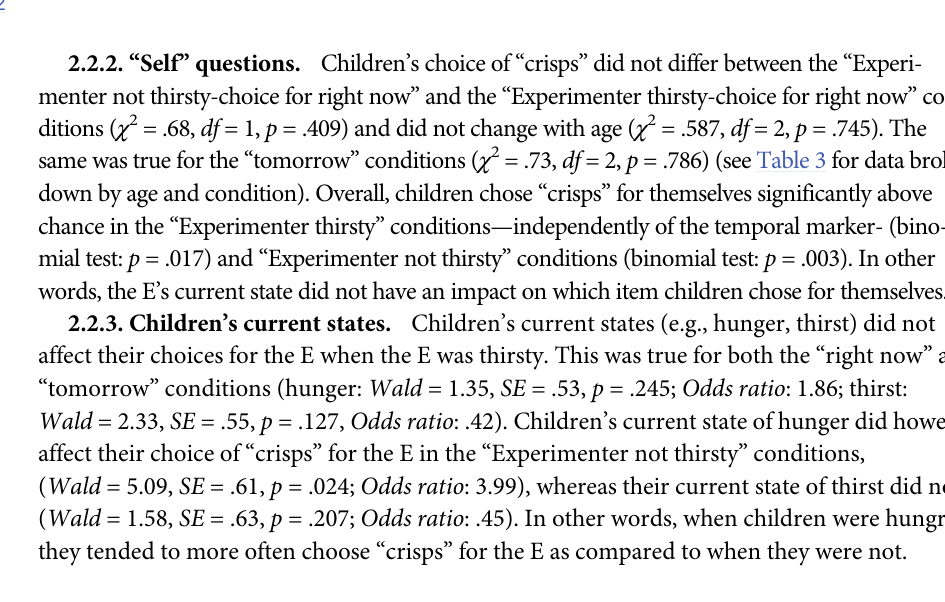
2.2.2. “Self” questions. Children’s choice of “crisps” did not differ between the “Experi-